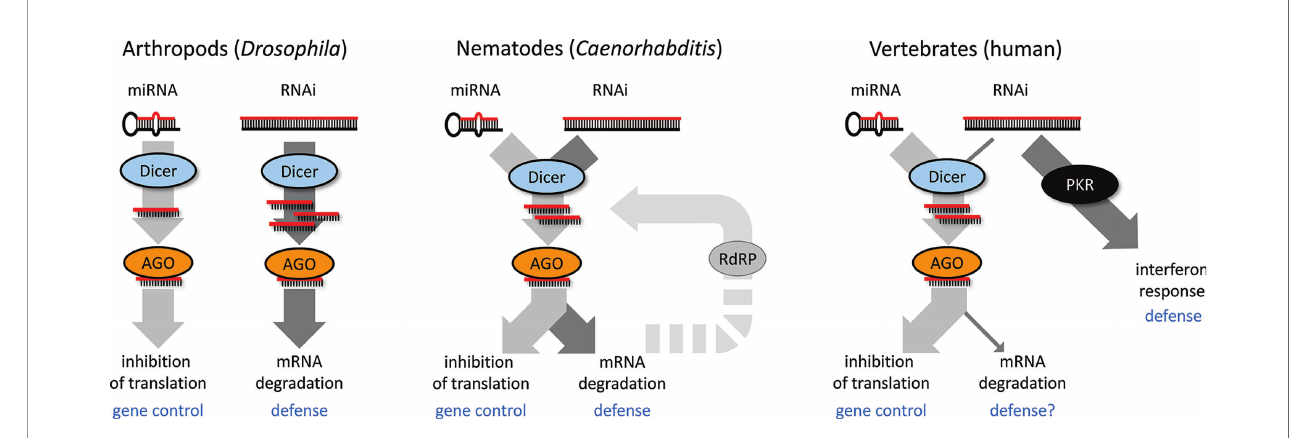
FIGURE 2 | Different scenarios of co-existence of RNAi and microRNA (miRNA) in